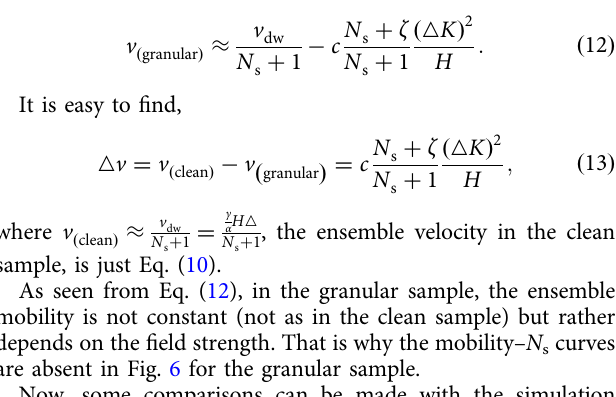
according to the simulation results η ¼ π R 1